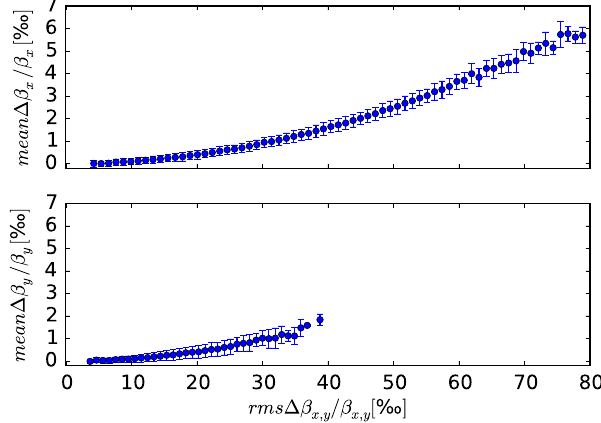
FIG. 8. Average β -beating vs rms β -beating (binned) of perturbed simulated lattices with respect to the unperturbed model of the ESRF storage ring